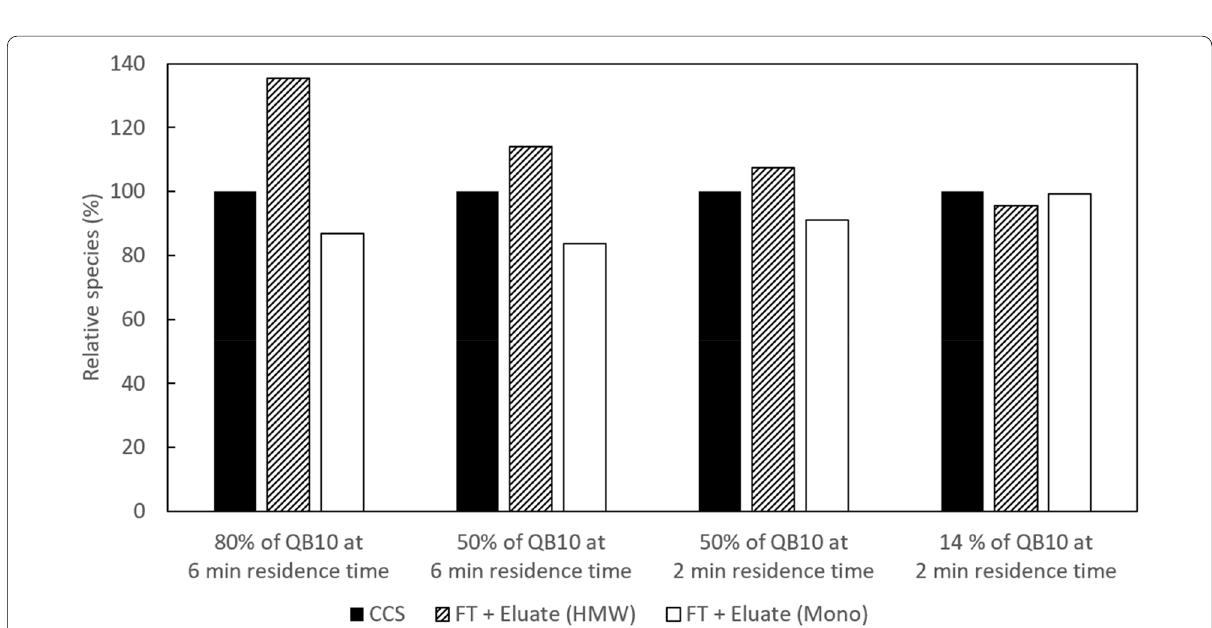
Fig. 5 Mass balance analysis of relative HMW and monomer species. Mass balance analysis of relative HMW and monomer species in CCS versus the total in FT and post-Protein A eluate at the different load and residence time studies. The black bar represents HMW amount in CCS as 100% when calculating the relative amount of HMW in FT eluate, and it represents Mono amount in CCS as 100% when calculating the relative amount + of Mono in FT +